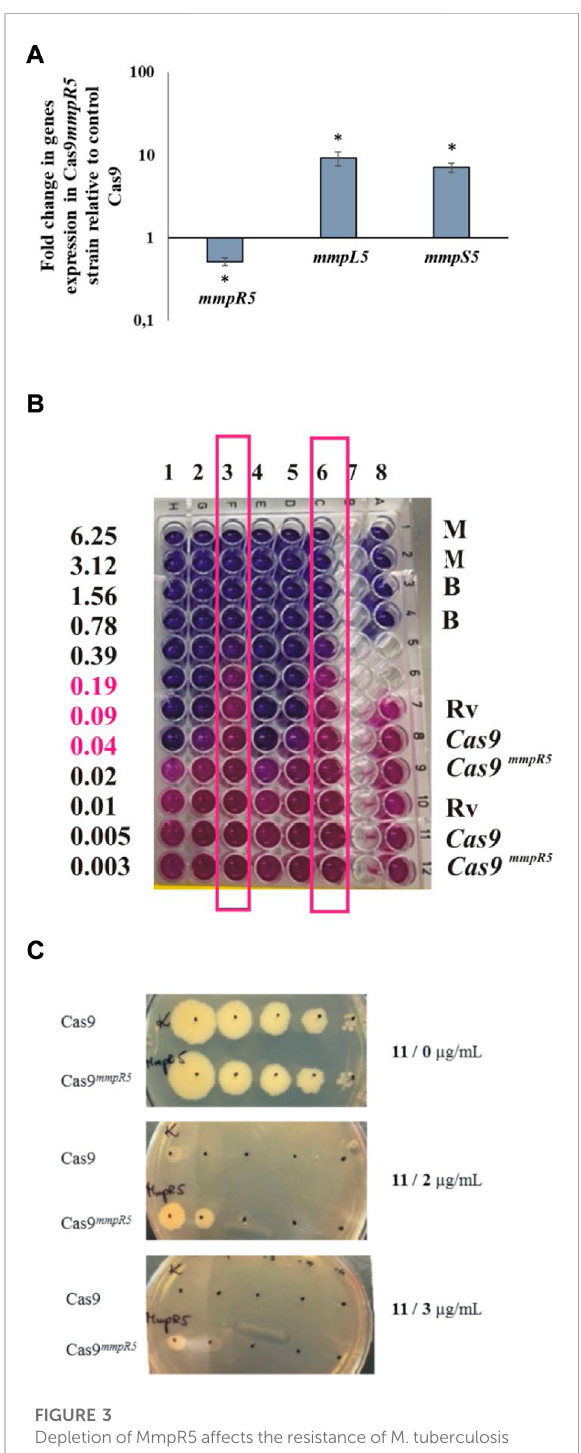
FIGURE 3 Depletion of MmpR5 affects the resistance of M. tuberculosis to compounds 11, 15, and bedaquiline. (A) Expression pro fi le of mmpR5, mmpL5, mmpS5 genes in CRISPR Cas9mmpR5